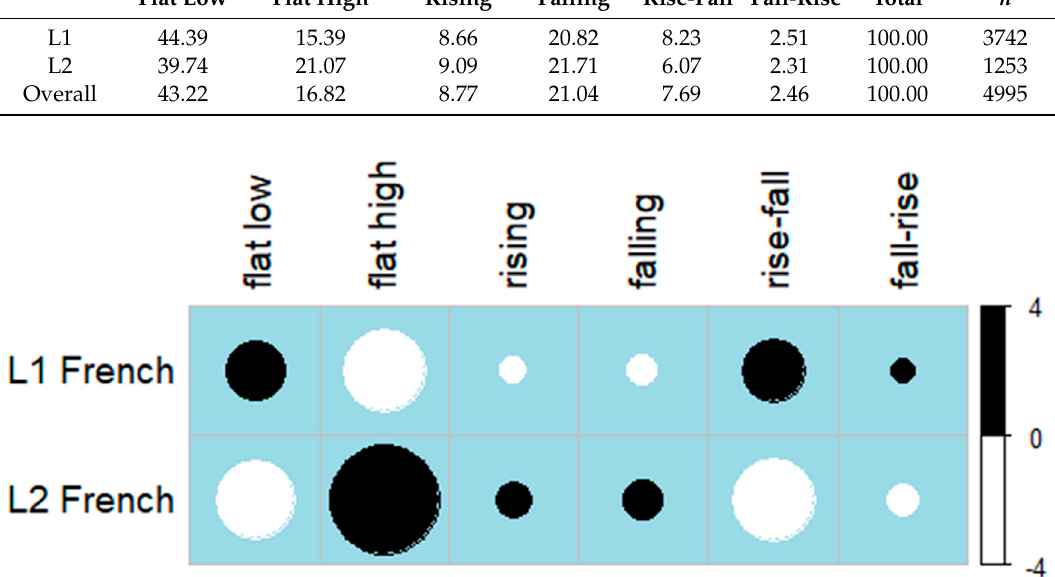
Figure 6. Correlation plot showing residuals of profile type and speaker